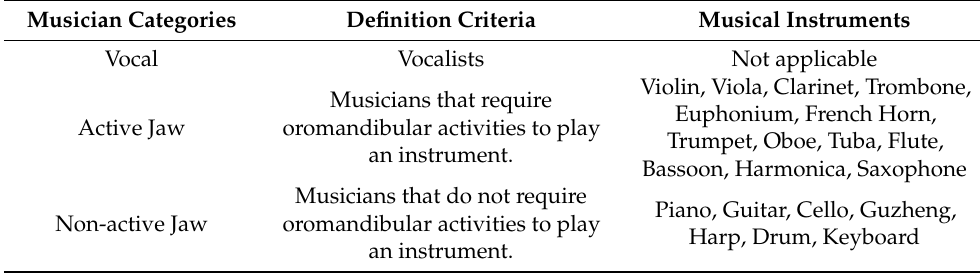
Table 1. Definition criteria for all musicians and their allocation into the 3 musician categories according to expert